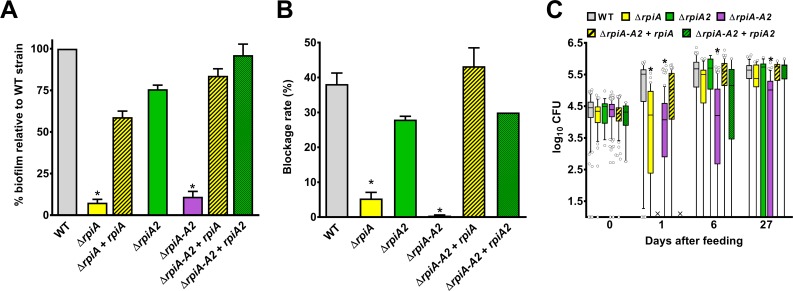
RpiA and RpiA2 are redundant in the production of a transmissible infection in fleas.We measured the ability of ΔrpiA (in yellow), ΔrpiA2 (in green) and ΔrpiA ΔrpiA2 (ΔrpiA-A2; in violet) mutants complemented or not with a high-copy-number plasmid harboring rpiA (yellow hatches) or rpiA2 (green hatches) to (A) form biofilms in vitro, (B) block fleas and (C) colonize fleas, relative to the WT strain (in grey). (A) The bars represent the mean ± SEM value from at least three independent experiments, except for the ΔrpiA ΔrpiA2 mutant complemented with rpiA2 (two experiments only). The ΔrpiA and the ΔrpiA ΔrpiA2 mutants produced significantly less biofilm than the WT and the complemented strains (*: p<0.01 in a one-way analysis of variance). (B) The bars represent the mean ± SEM from three independent experiments (ΔrpiA and ΔrpiA ΔrpiA2 mutants), two independent experiments (ΔrpiA2 and ΔrpiA ΔrpiA2 + rpiA) or one experiment (ΔrpiA ΔrpiA2 + rpiA2 mutant). The ΔrpiA and ΔrpiA ΔrpiA2 mutants blocked significantly fewer fleas than the WT strain (*: p<0.01 in a one-way analysis of variance). (C) Box-and-whisker plots (5–95% percentiles) show the bacterial loads determined from up to 20 fleas in each experiment (i.e. a total of 50 to 259 fleas). The result of one experiment (ΔrpiA2 D6 and ΔrpiA ΔrpiA2 + rpiA2 at all time points) and the cumulative results of two experiments (ΔrpiA D27) and ≥ three experiments (all other strains and time points) are shown. Symbols indicate outliers. X: not determined. The bacterial loads for the ΔrpiA strain were significantly lower than for the WT strain at D1, whereas those for the ΔrpiA ΔrpiA2 strain were significantly lower throughout the experiment (*: p<0.01 in a one-way analysis of variance). The ΔrpiA2 mutant and the complemented mutants behaved like the WT strain.